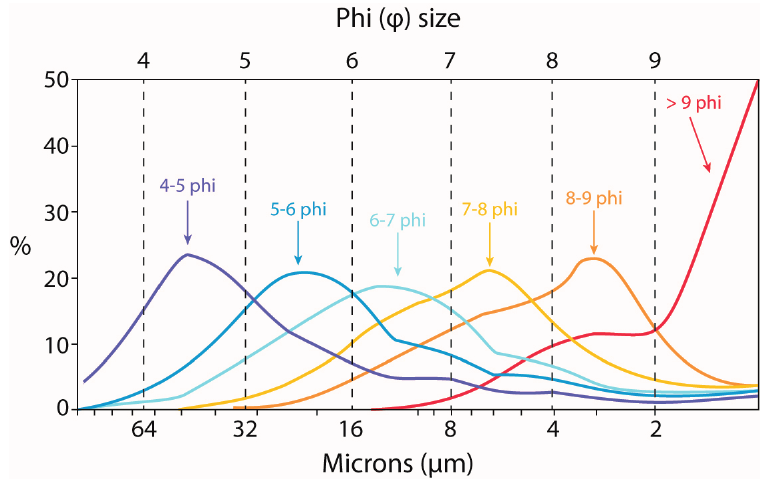
Figure 7. Laser granulometry measurements of the particle size distribution of separated sediment fractions. Note that the mode occurs within the target range but it accompanied by large tails overlapping into different particle size bins. The coarser fractions are more positively skewed being enriched in fines, while the fines are more negatively skewed being enriched in coarser grains. Figure redrawn from Walden and Slattery